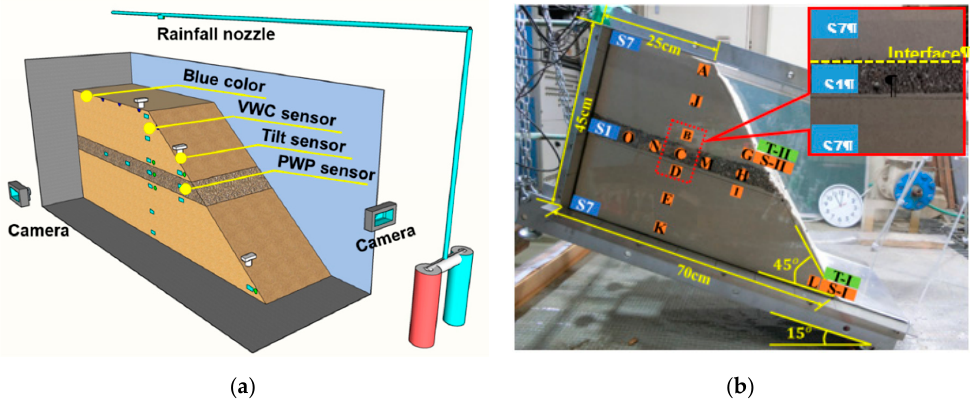
Figure 4. ( a ) Schematic diagram of the experimental apparatus used for a multi-layered slope under rainfall: side-view of the multi-layered slope; ( b ) side view of the experimental apparatus used for the slope. The yellow dashed line shows the fine–coarse interface.